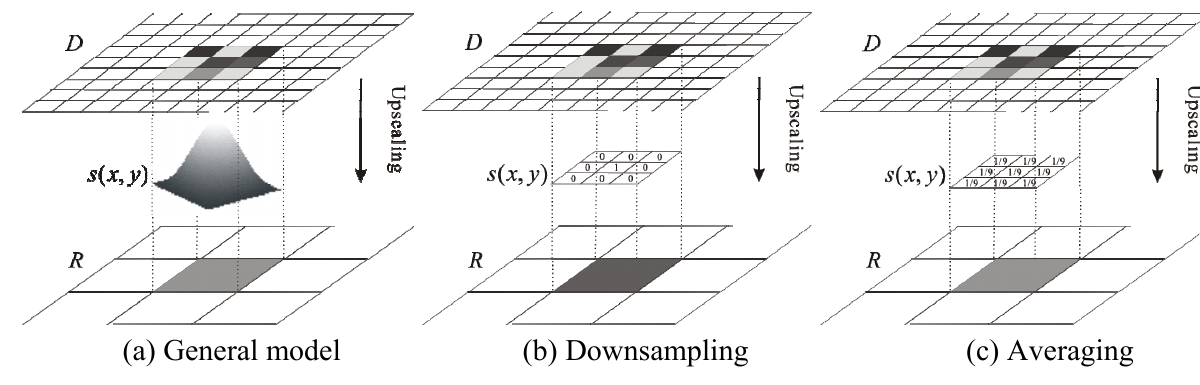
Figure 3. Information transfer function s